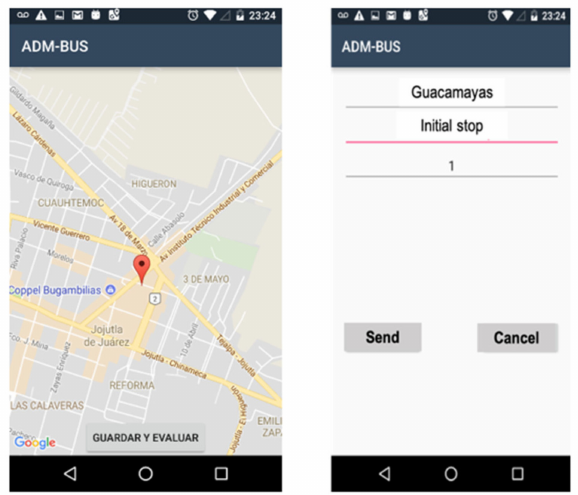
Figure 14. Interface to define the location of a bus